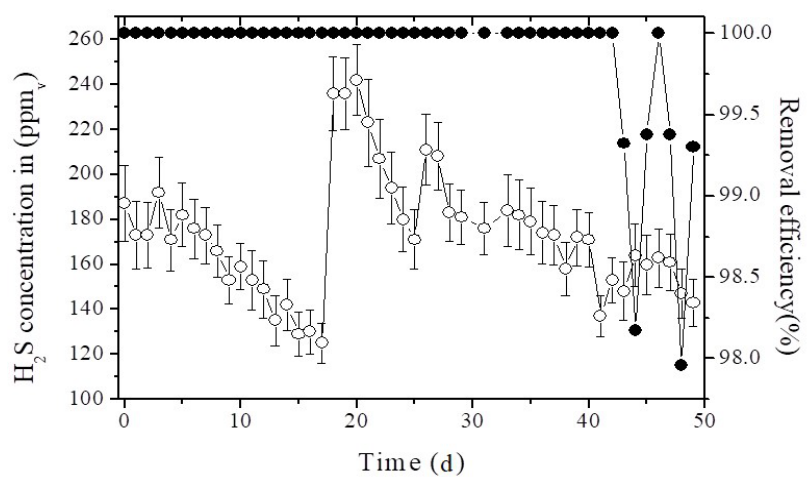
Figure 5. Performance of the HSPS in the landfill. H 2 S inlet ( ○ ) and removal efficiency (●).